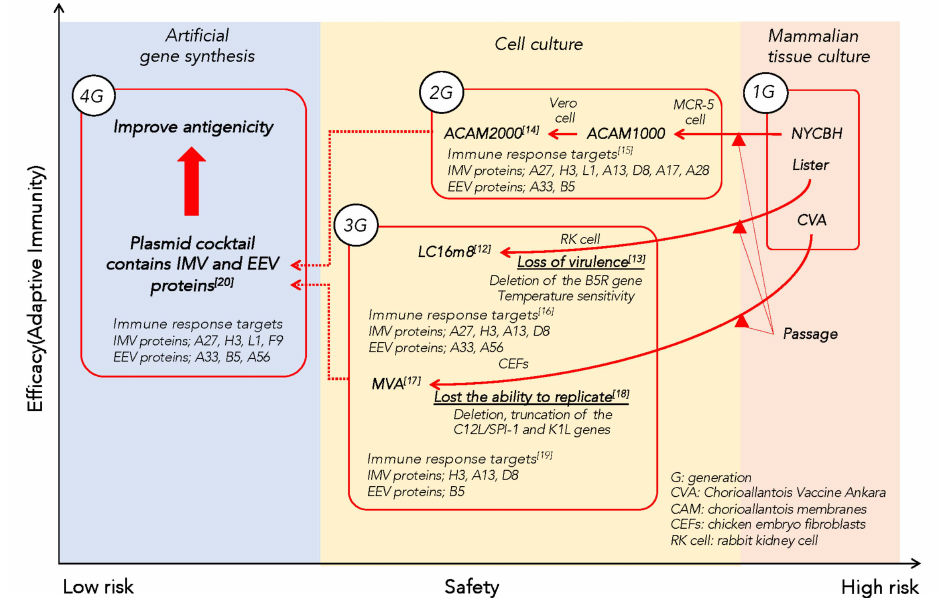
Figure 1. Classification of smallpox vaccine based on safety and efficacy. The different smallpox vaccines can be classified into 1st to 4th generations that are positioned as shown in the figure from the viewpoint of safety and efficacy. Safety is the avoidance of the risk of adverse events, and efficacy can be assessed by adaptive immunity, including cell-mediated immunity (take rate) and antigenicity. The first-generation NYCBH, Lister and CVA strains, which are considered to be the parent strains, were switched in cell culture to produce second-generation ACAM1000 and ACAM2000 with improved quality and efficiency in mammalian cell culture. Cell culture passaging shifts to the third generation LC16m8, which has weakened infectivity, and MVA, which has a weakened ability to replicate.